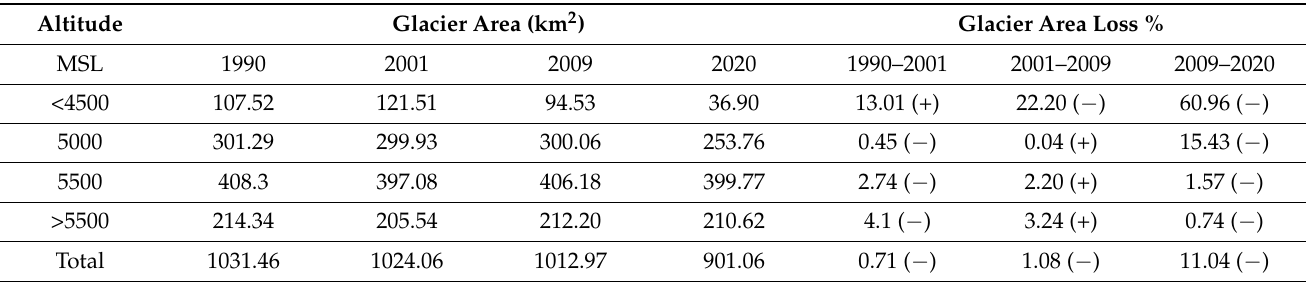
Table 5. Glacier area and changes at different elevation zones in different years (1990–2020)